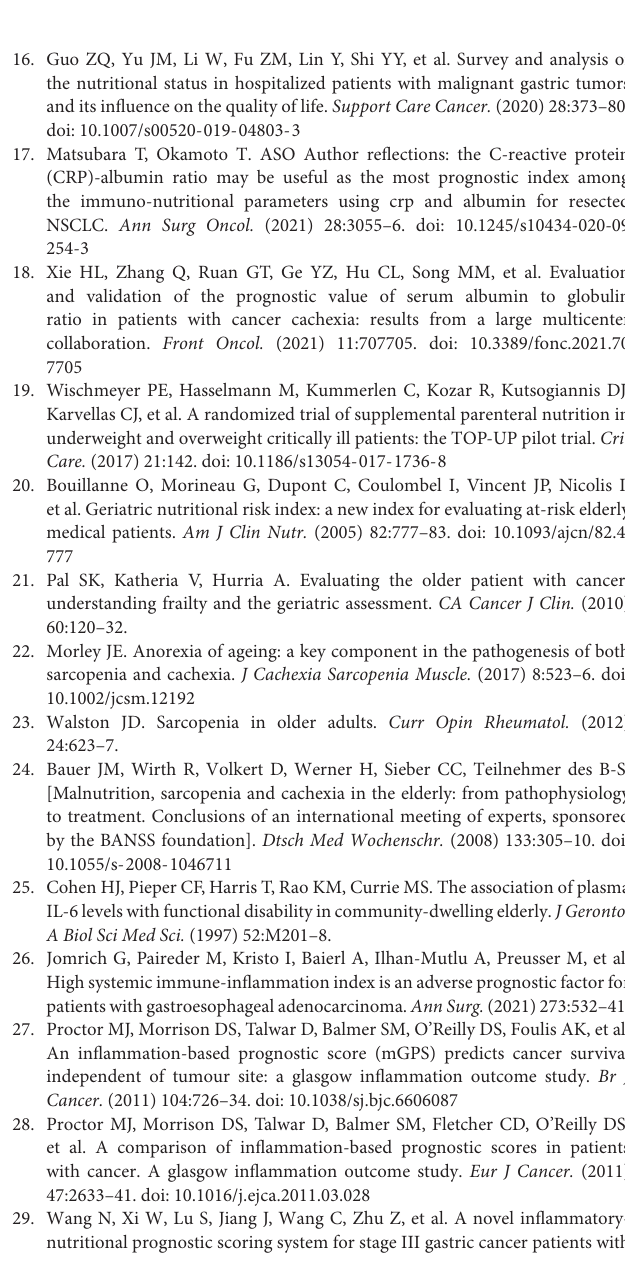
Supplementary Figure 5 | The Kaplan–Meier survival curve of PGSGA. Notes: PGSGA: patient-generated subjective global